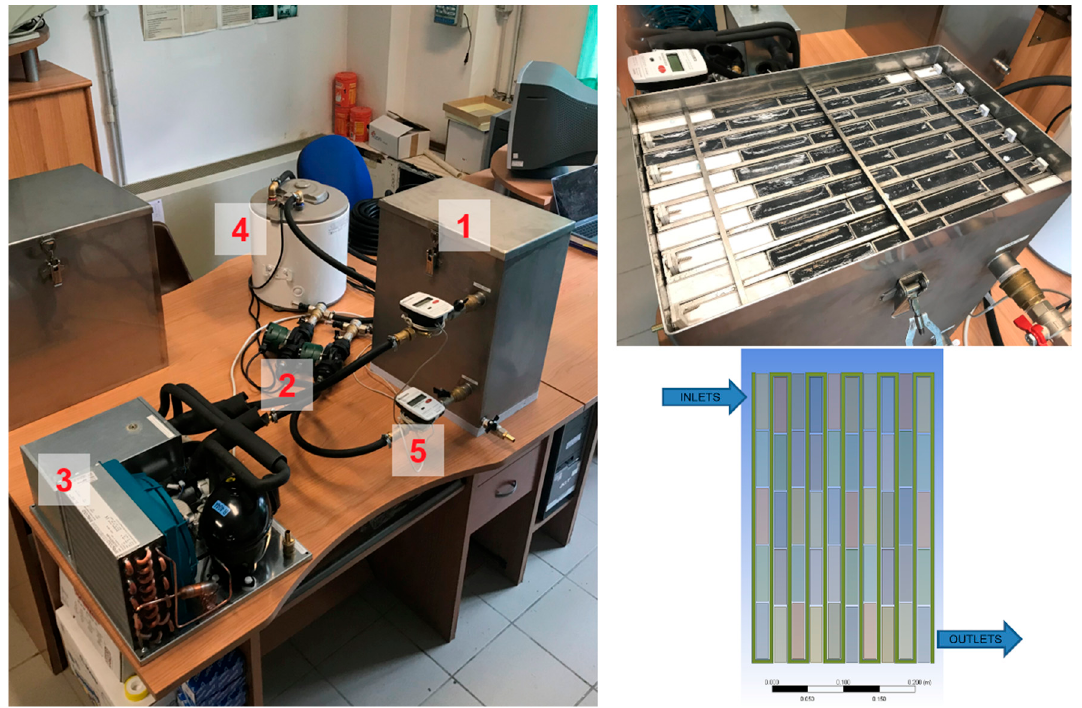
Figure 2. ( left ) Overview of the experimental layout. 1: phase-change-material (PCM) thermal storage, 2: circulating pumps, 3: chiller, 4: heater, 5: temperature/flow meters. ( right ) Close view of the PCM storage and top view of its geometry model.